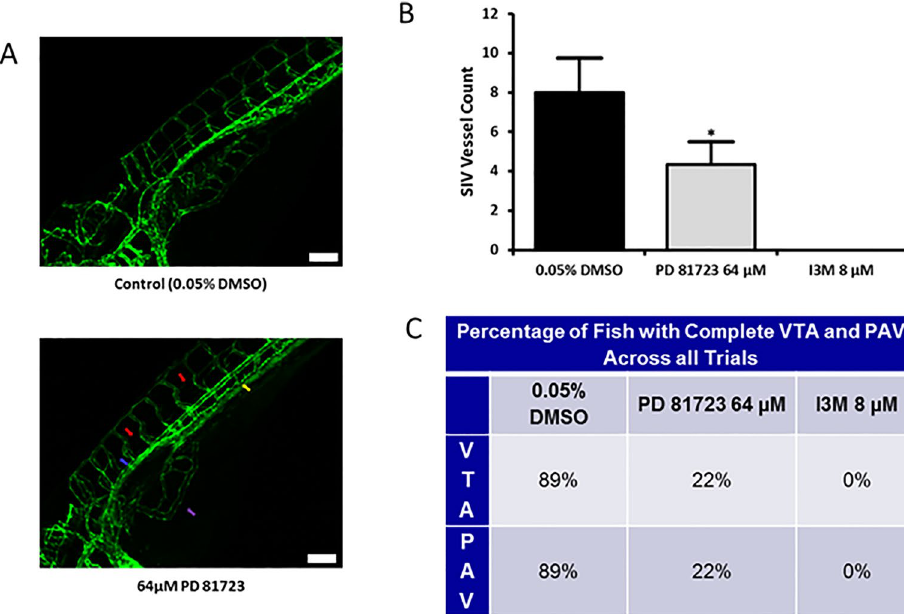
Figure 3. PD 81,723 inhibits the development of SIVs, the VTA, and the PAV. ( A ) Confocal images comparing the vascular phenotype of Tg(kdrl:EGFP) zebrafish at 4 dpf treated with 0.05% DMSO and 64 µM PD 81,723 at the cranial end and focusing on the area surrounding the SIVs. The red arrows indicate a missing vertebral artery (VTA) and the blue arrow indicates a missing parachordal vessel (PAV). The yellow arrow indicates a reduction in the vasculature where the ISVs meet the posterior cardinal vein (PCV). The purple arrow is pointing to the region where the SIVs are malformed. Scale bars are 100 µm. ( B ) SIV counts at 4 dpf in zebrafish dosed with 0.05% DMSO, 64 µM PD 81,723, or 8 µM I3M. There was a significant decrease (* = P < 0.05 vs. control) in the number of vessels sprouting from the SIVs basket in the fish dosed with 64 µM of PD 81,723 when compared to the control. The experiment was repeated in triplicate with an N = 3 for each condition in each experiment. The error bars represent the standard deviation of the SIV counts from the three experiments. ( C ) Table showing that only 22% of the fish dosed with PD 81,723 had complete VTA and PAV, compared to 89% in the control, across all three